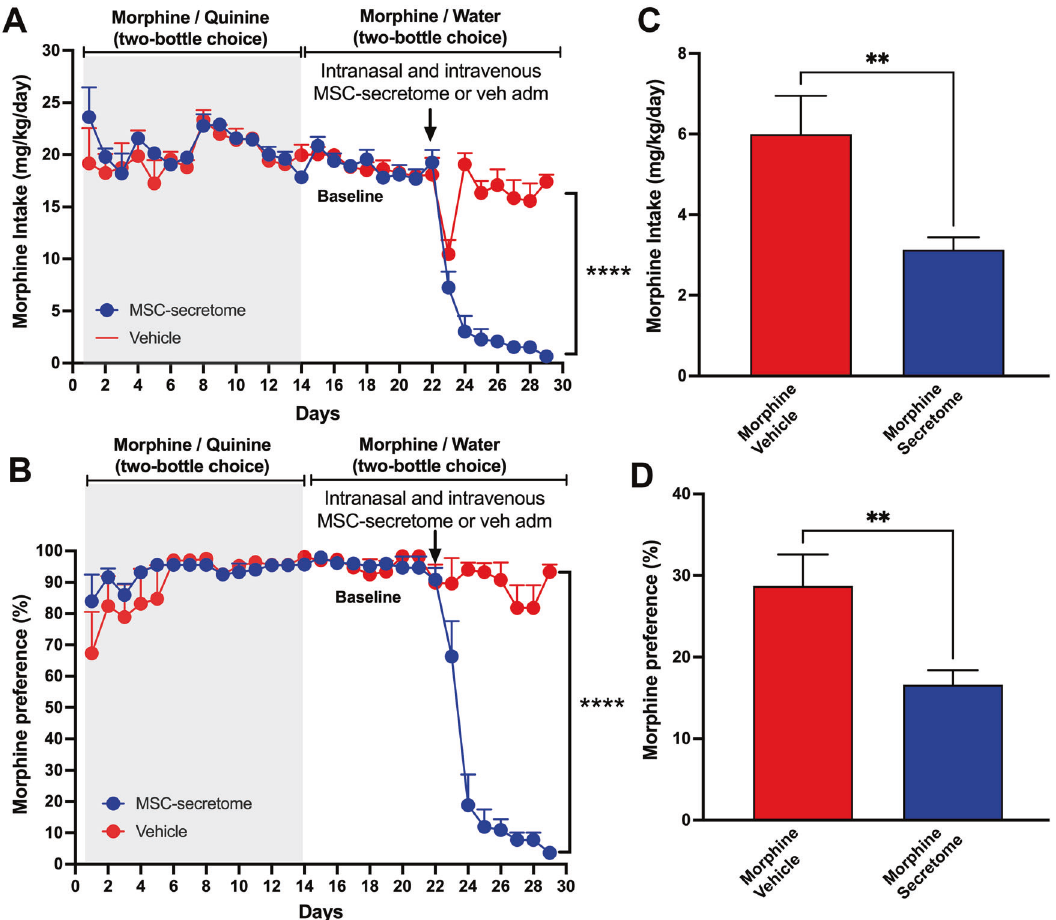
Fig. 1 Simultaneous intranasal and intravenous administration of secretome derived from human preconditioned MSCs to Wistar rats that had chronically consumed morphine inhibits morphine intake and reduces post-deprivation morphine re-access intake. A Daily morphine intake and ( B ) morphine preference over water. Wistar rats that had voluntarily ingested morphine for 21 days were simultaneously intranasally and intravenously treated with secretome (25 μ g protein) derived from 1 × 10 6 preconditioned MSCs or vehicle (indicated by the arrow). Morphine intake was inhibited by 95% ( p < 0.0001). Two-way ANOVA (treatment x day) of morphine intake and morphine preference following secretome administration (blue circles) indicate signi fi cant effect of treatment (F (1,435) = 158.9 **** p < 0.0001), day (F (28,435) =